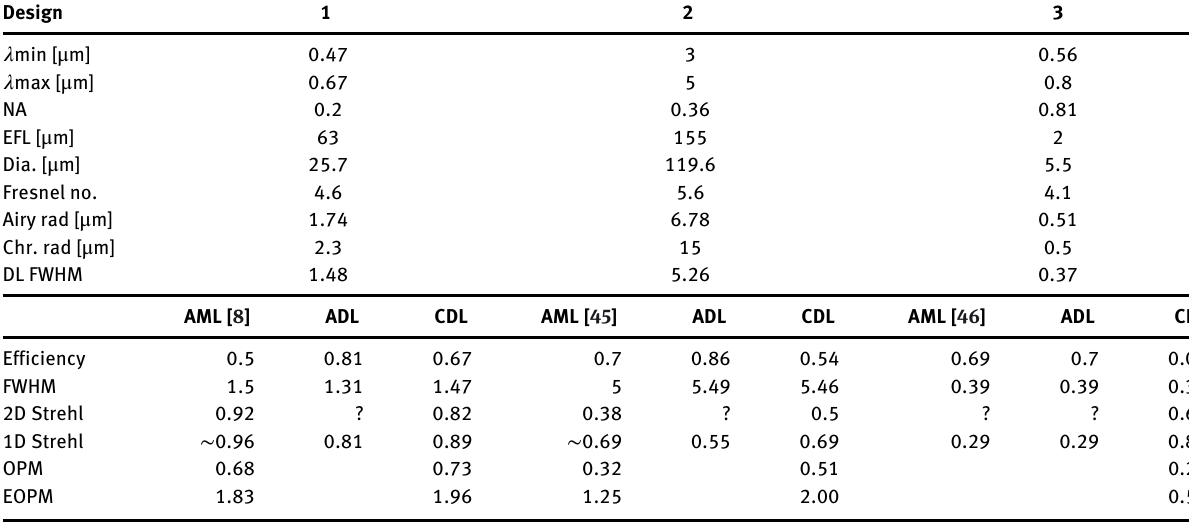
Table 2: Comparison of achromatic diffractive lenses (ADLs) of [44] and achromatic metalenses (AMLs) quoted therein to equivalent conventional diffractive lenses